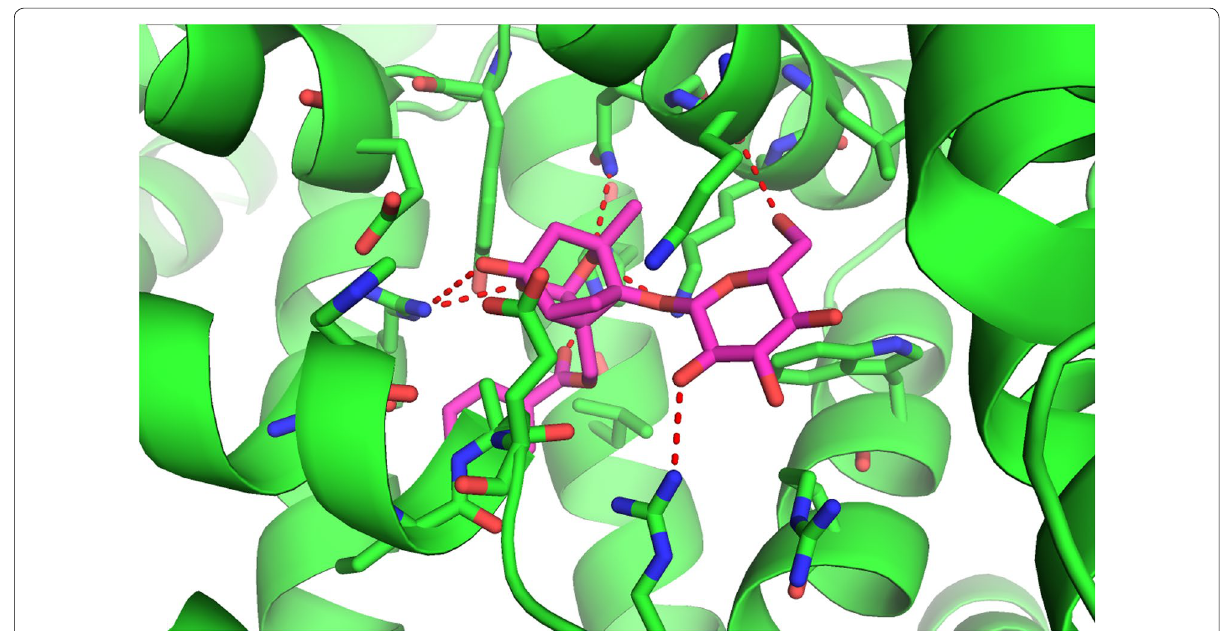
Fig. 12 The active site residues of HSA and paeoniflorin. The HSA is presented by ribbon structure whereas paeoniflorin by stick